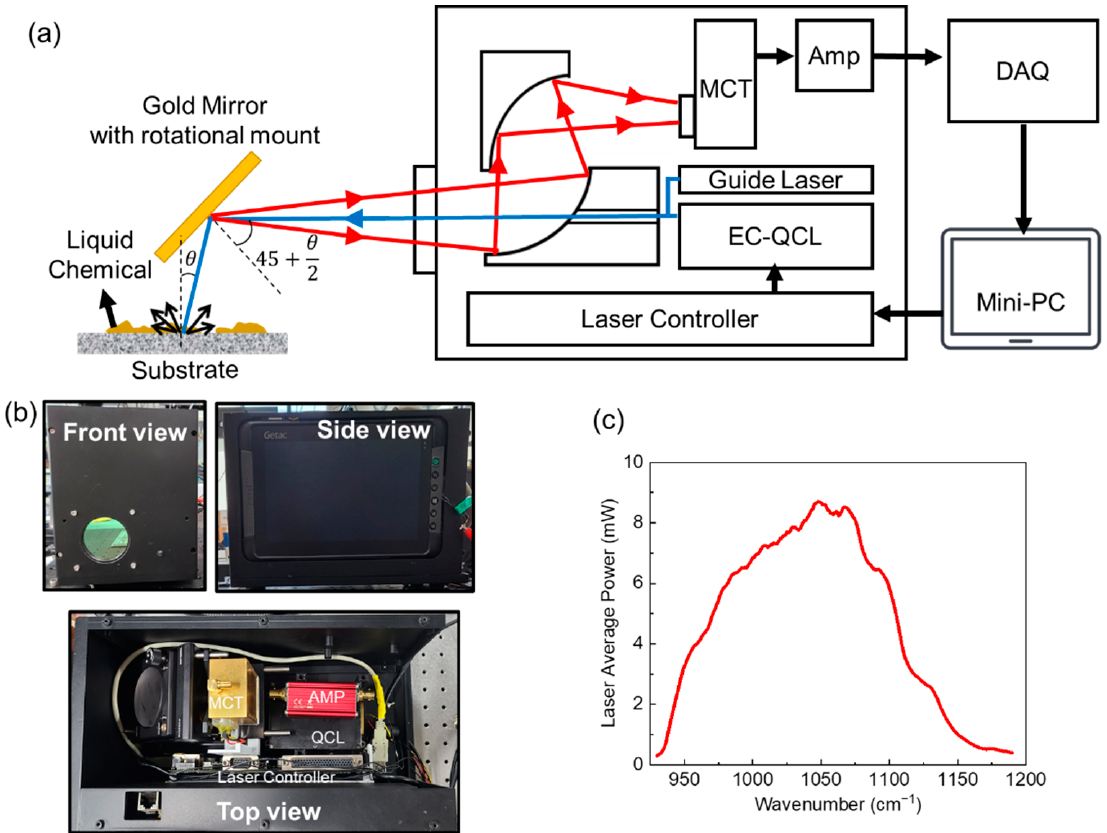
Figure 1. ( a ) Schematic of the detector with block diagram and measurement configuration. The blue and red arrow indicate incident light from the lasers and reflected light from the target substrate, respectively. ( b ) Front (top left), side (top right), and top view (bottom) images of the detector. ( c ) Averaged QCL power spectra measured at the position of the target substrate.